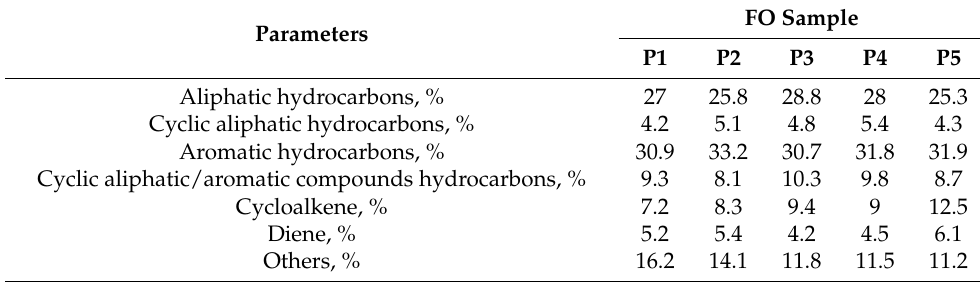
Table 1. The low-temperature properties of the tested